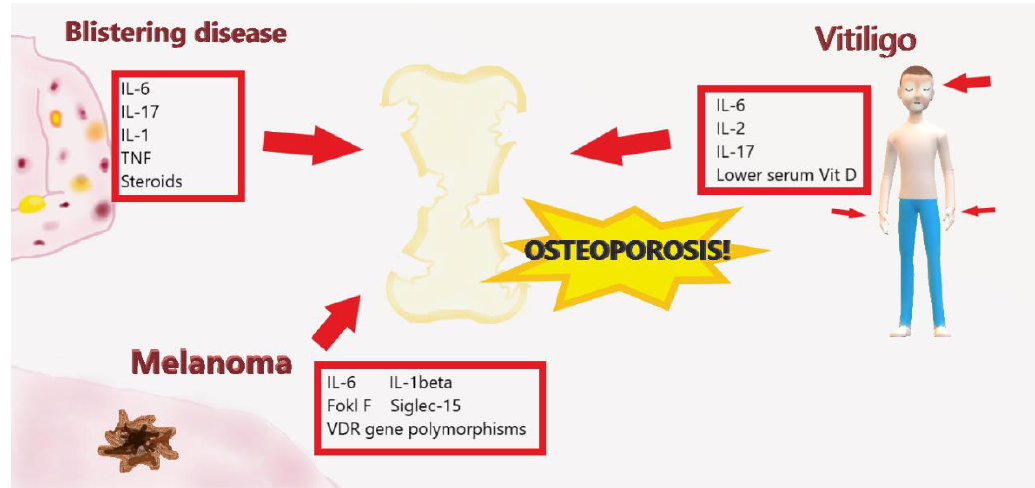
Figure 6. Cytokine interaction between osteoporosis, vitiligo, melanoma, and pemphigus. The action of cytokines produced during vitiligo (IL-6, IL-12, IL-17), melanoma (IL-6, IL-1 beta, FokI F, Siglec-15), and pemphigus (IL-6, IL-17, IL-1, TNF) are involved in the process of bone resorption.